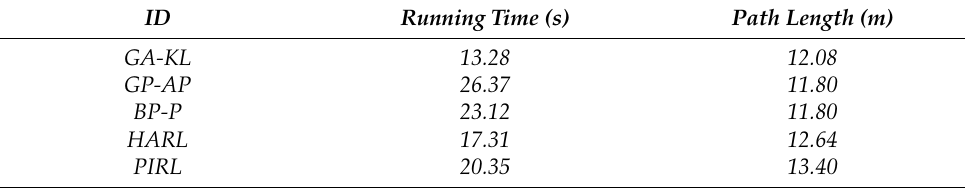
Table 8. Run time and path length for five rounds of path planning.